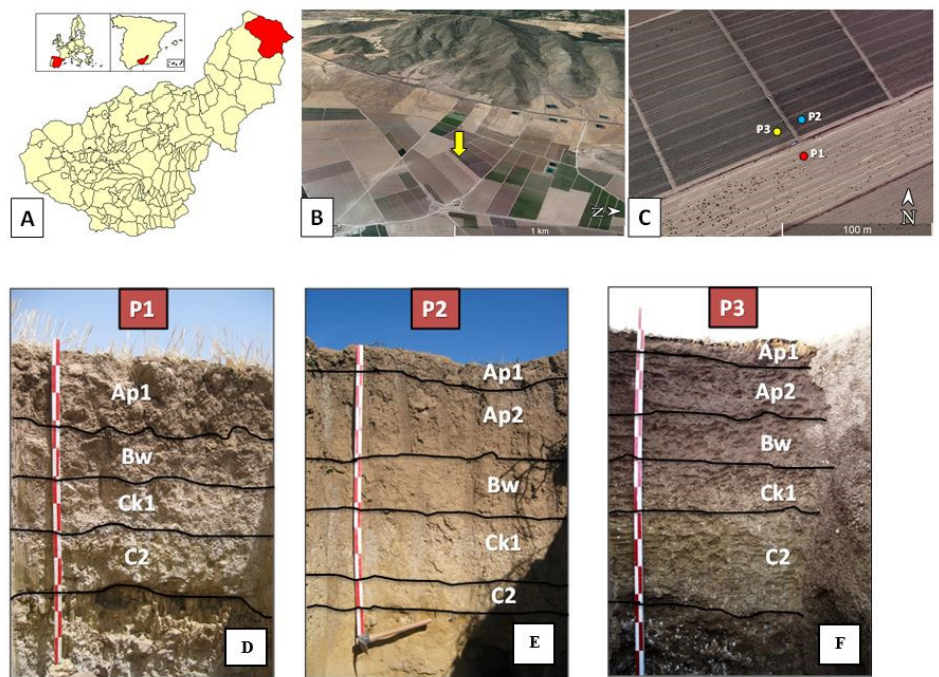
Figure 1. ( A ) Geopolitical situation of the study area. CC-BY-SA 3.0. Accessed: 22-04-2021. ( B ) Over- head view of the experimental plot (yellow arrow). ( C ). Detail of the plot, showing the P1 (red), P2 (blue), and P3 (yellow) locations. ( D – F ) View of the three profiles (P1, P2, and P3) before sampling. The horizons were determined using the FAO Guidelines for Soil Description (FAO, 2006) and are delimited by black lines.